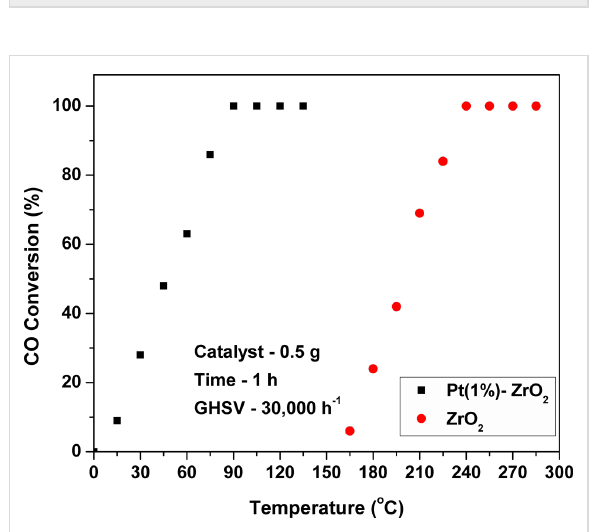
Figure 7: FTIR spectra of (a) ZrO 2 and (b) Pt(1%)-ZrO 2 .